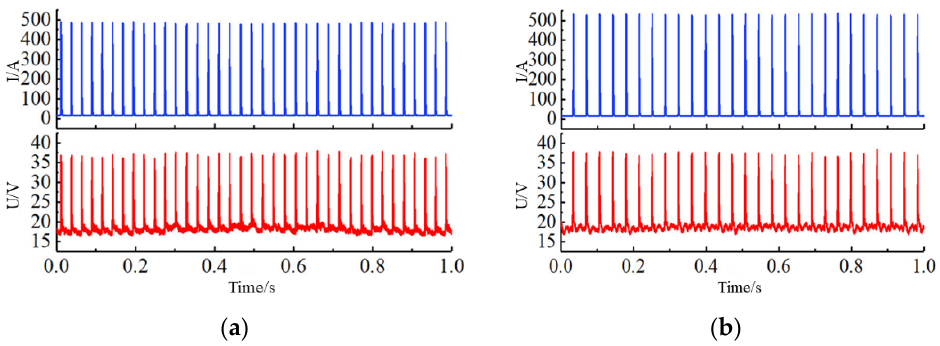
Figure 5. The current and voltage waveform in P-GMAW: ( a ) I p = 485 A, I = 60 A; ( b ) I p = 525 A, I = 60 A.